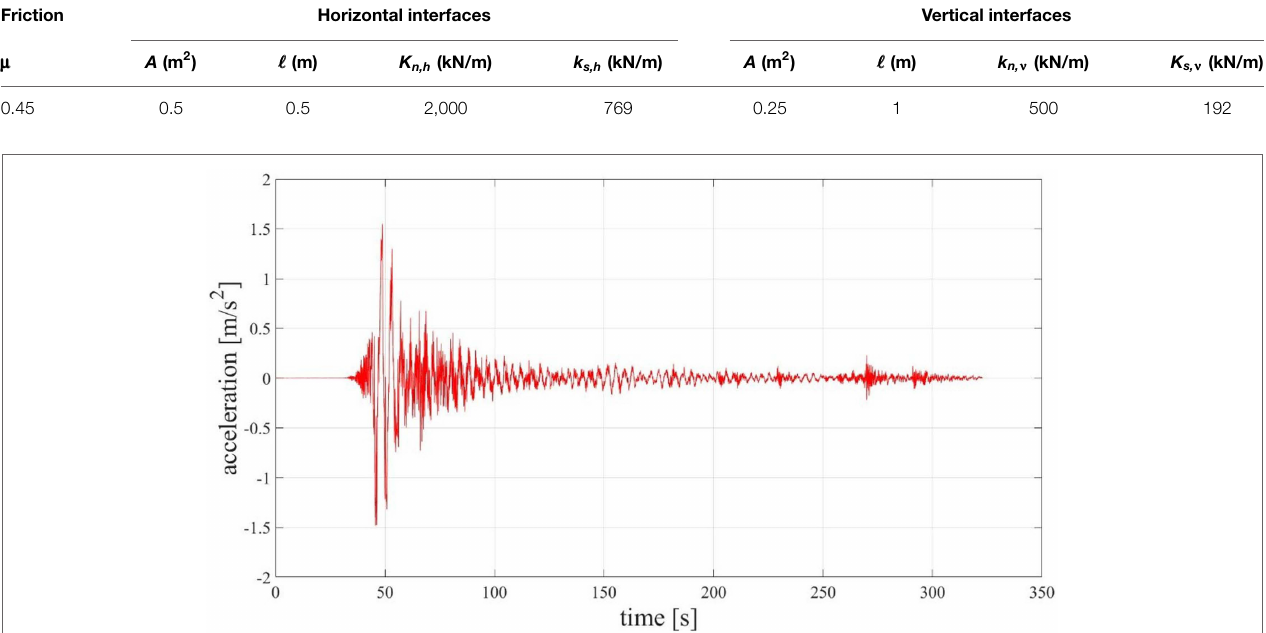
TABLE 5 | Joint properties for entire gabion-boxes.